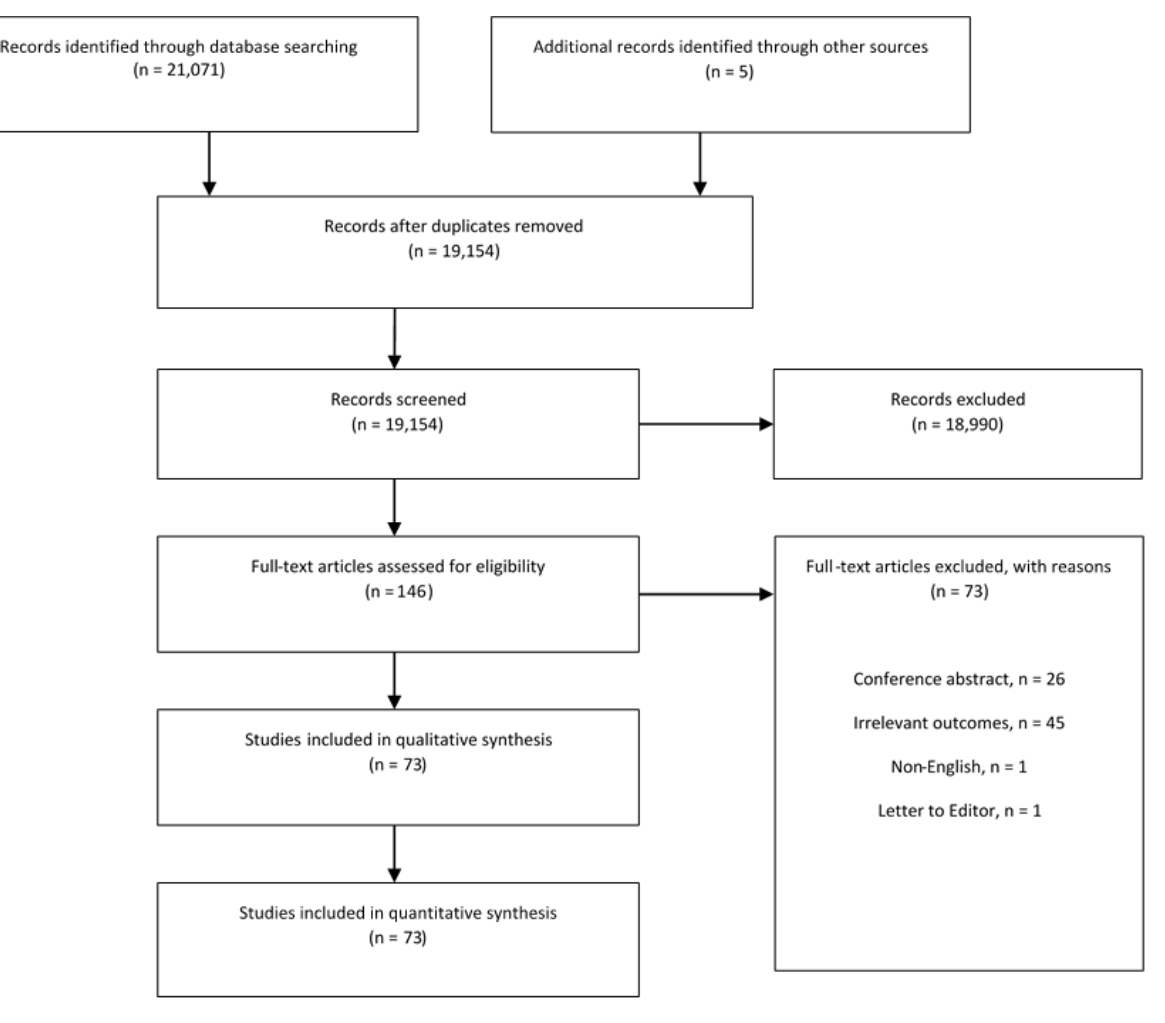
Figure 1. PRISMA Flowchart. Table 1. Summary of identified risk factors associated with the development of ESCC.